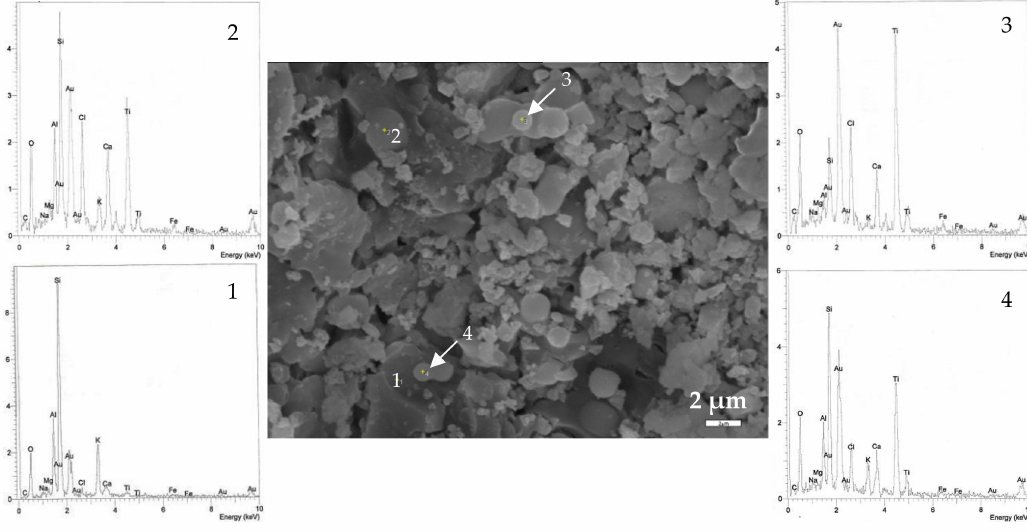
Figure 4. SEM image (4000 × ) and energy spectrum analysis ( 1 – 4 ) of the coated reference sample S0, after annealing at 600 ◦ C for 1